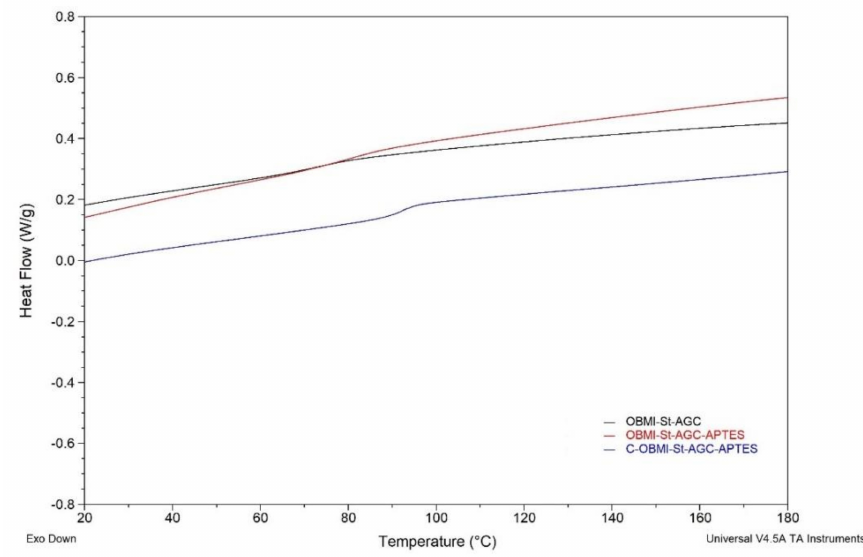
Figure 10. DSC thermograms of the polymer